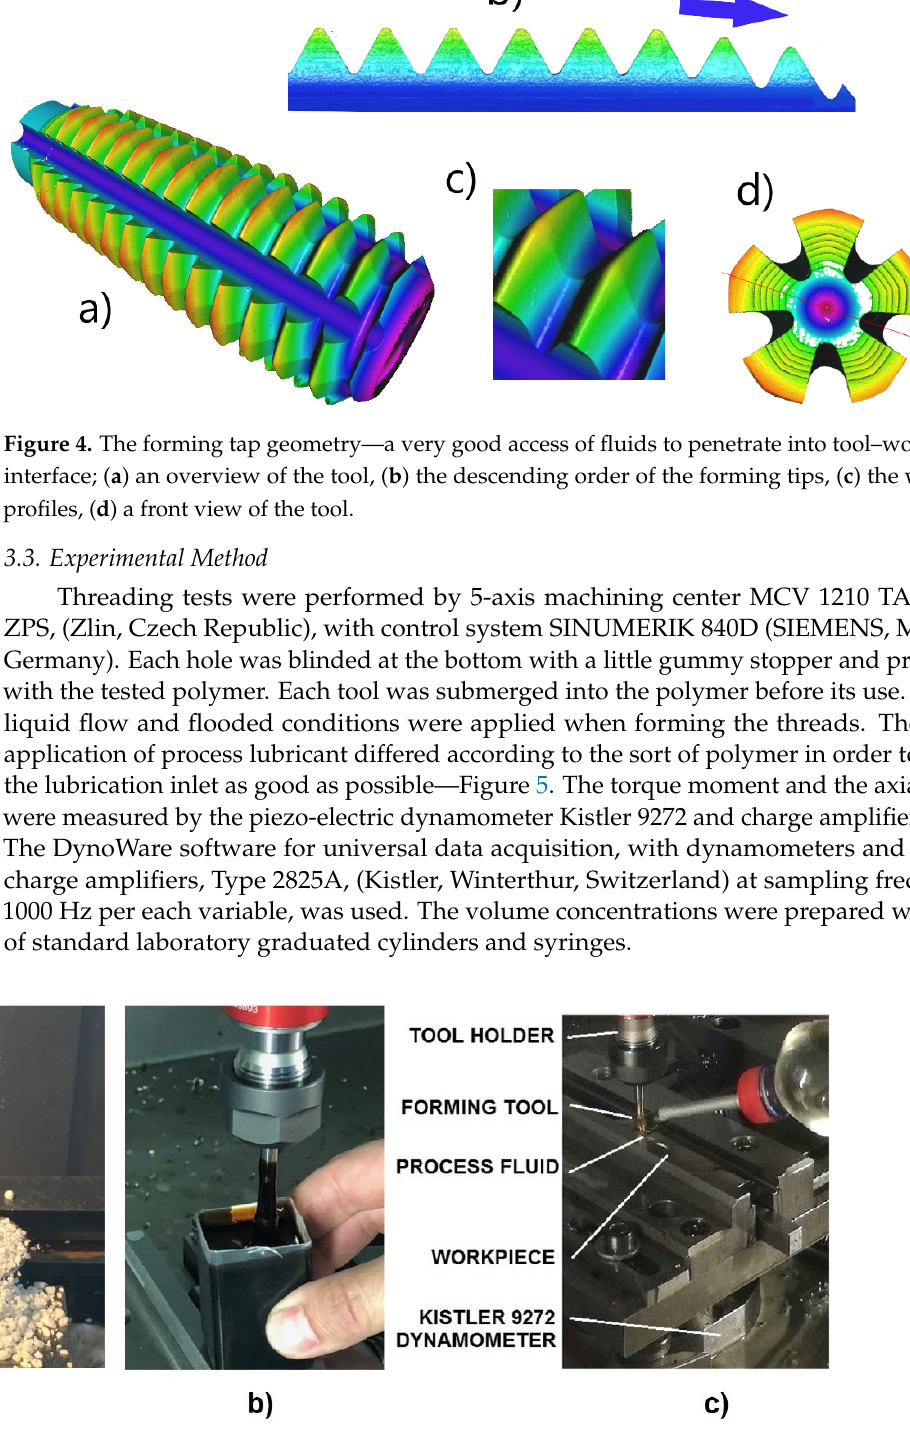
Figure 5. Application of polymers: the soap ( a ), the concentrate ( b ), and the diluted solution ( c ). The mathematical analysis of the cross-section of the material to be formed into thread confirmed a polynomial curve of the fifth order according to its length—Figure